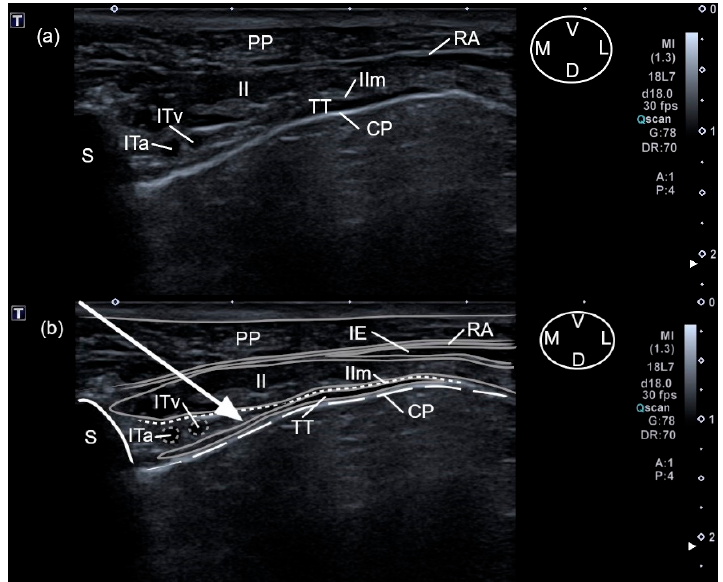
Figure 2. ( a ) Anatomical structures visualized during the two-point ultrasound-guided injection technique for the transverse approach to the transversus thoracis plane at the third intercostal space in a canine cadaver. ( b ) The same visualization of the anatomical structures with the edges of the muscles highlighted to improve the identification (solid grey lines), the internal intercostal membrane (short dashed white lines), third sternebra (solid white line), vascular structures (short dashed grey lines) and costal pleura (long dashed lines). The arrow shows the pathway followed by the needle before reaching the transversus thoracis plane. CP, costal pleura; D, dorsal; IE, external intercostal muscle; II, internal intercostal muscle; IIm, internal intercostal membrane; ITa, internal thoracic artery; ITv, internal thoracic vein; L, lateral; M, medial; PP, pectoralis profunda muscle; RA, rectus abdominis muscle; S, Sternum; TT, transversus thoracis muscle; V,